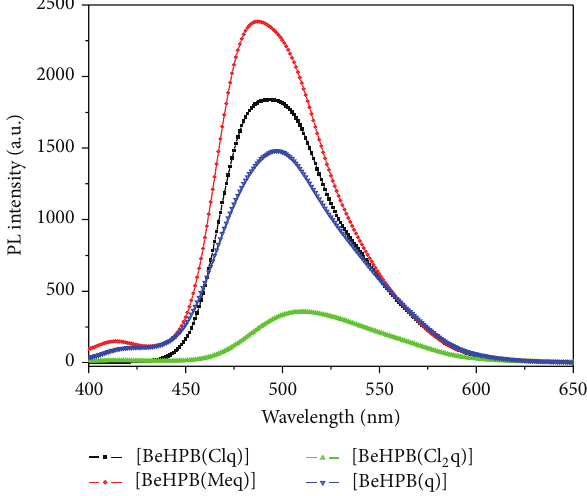
Figure 6: Photoluminescence spectra of beryllium(II) complexes in thin film form on glass substrate.